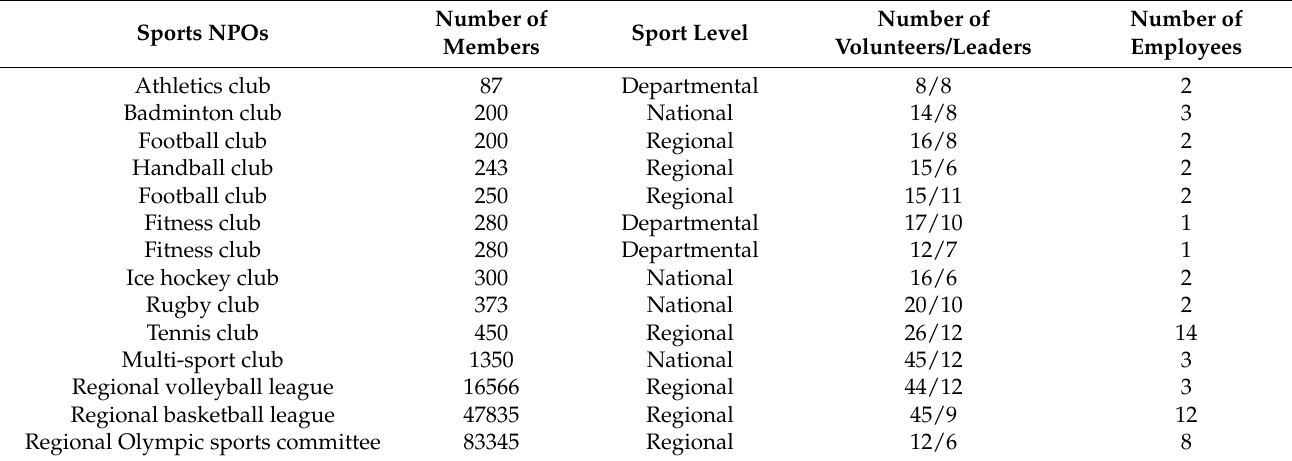
Table A1. List of sports NPOs and cities